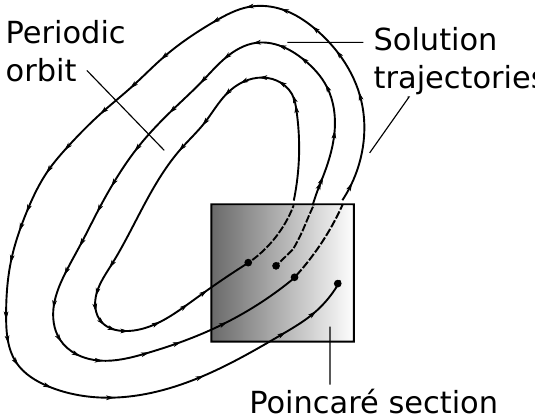
Figure 4. A Poincaré section is formed by taking intersections of a system’s solution trajectories after each iteration/period of the flow. Here a periodic orbit sees a solution return to the same point after each iteration. By contrast, another trajectory, initially starting close to this periodic point moves throughout the